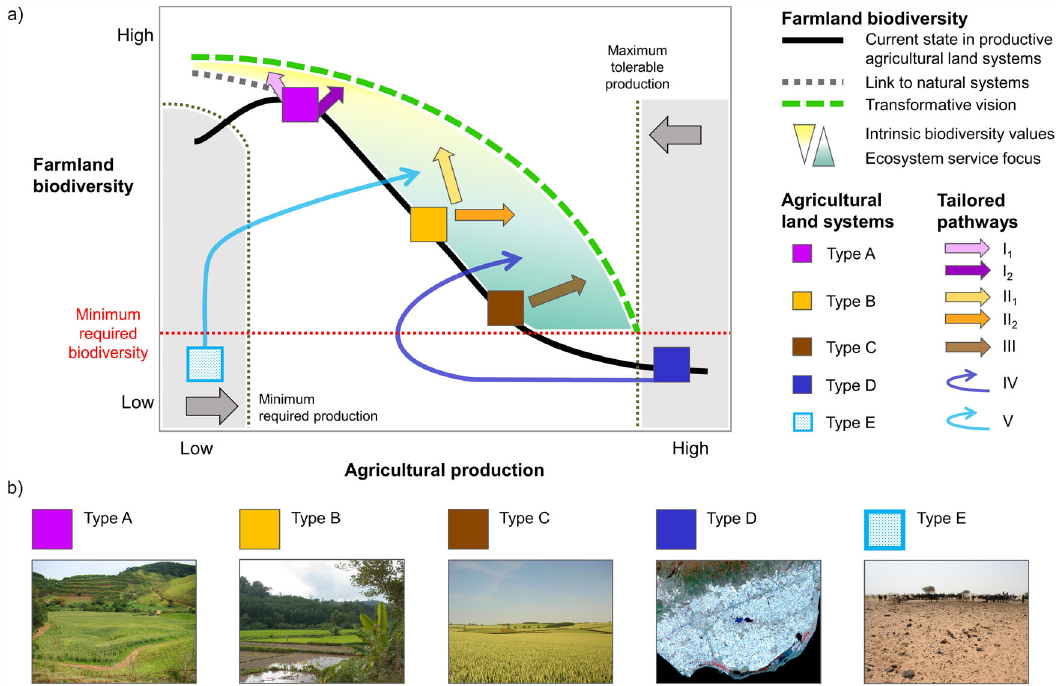
Fig. 1 Conceptualisation of the general relationship between agricultural production and farmland biodiversity together with tailored pathways toward enhanced farmland biodiversity. a Declining non-linear relationship between agricultural production and farmland biodiversity. Pathways I to III are summarised as straight arrows representing overall directions. In contrast, pathway IV involves sequential changes involving de-intensi fi cation and restoration action followed by slight re-intensi fi cation, while pathway V relies on restoration followed by slight re-intensi fi cation. Different lengths of arrows indicate differences in required changes of production and resulting biodiversity improvement. b Example photographs of agricultural land system types depict: Type A – Low-intensity livestock system in very diverse mountainous landscape including a protected area in the upper part, southeastern Brazil, Type B – Medium-intensive rice production in diverse landscape with forest remnants, western Philippines, Type C – High-intensity cereal cropping in very simple, homogenised landscape, southern United Kingdom, Type D – Very intensive horticultural production in severely disturbed landscape due